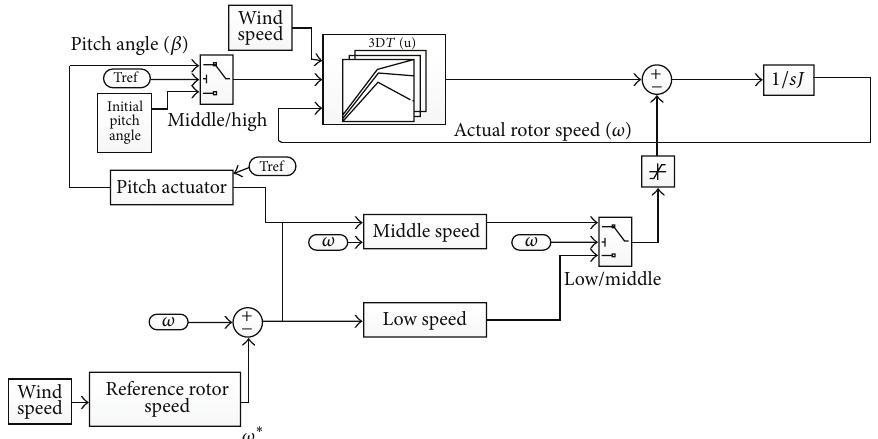
Figure 6: The controller scheme that is valid for the whole operational range.